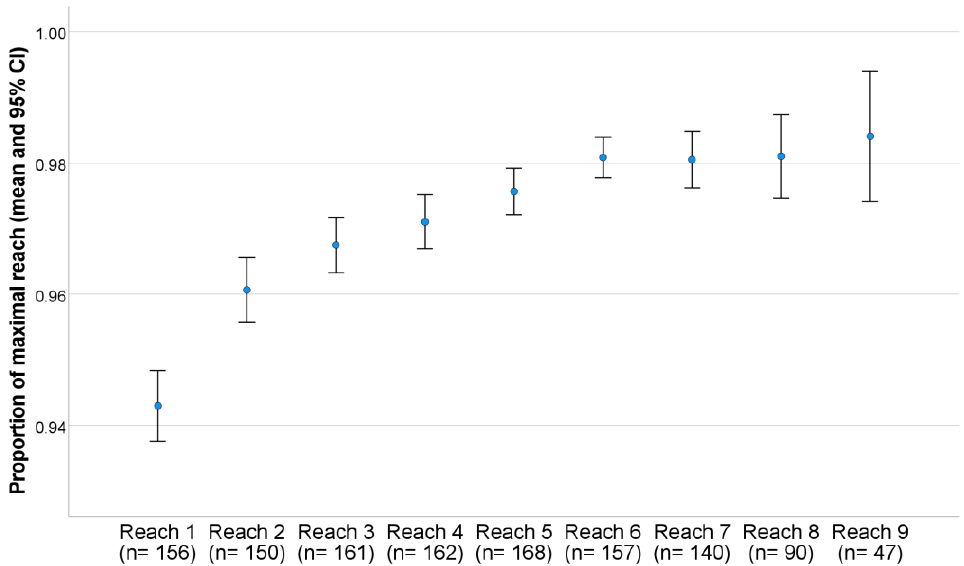
Figure 2. Plateauing of the results was reached after the sixth successful repetition.